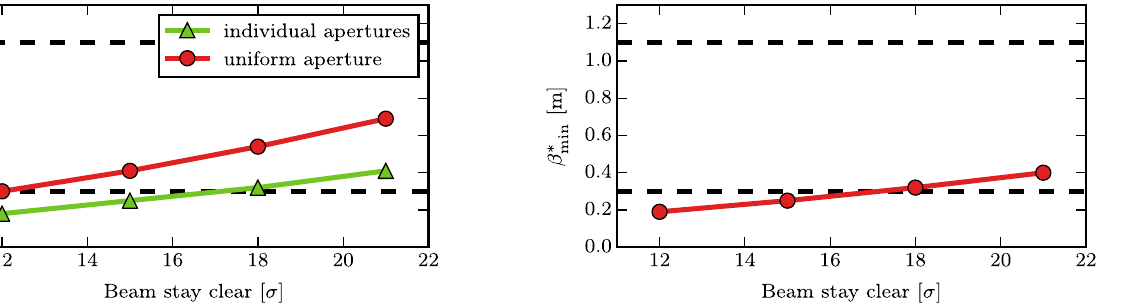
FIG. 7. Minimum β (cid:2) of the L (cid:2) ¼ 36 m lattice for beam star clear requirements of 12 – 21 σ . The baseline goal of β (cid:2) ¼ 1 . 1 m poses no problem from the aperture point of view. The “ ultimate ” goal of β (cid:2) ¼ 0 . 3 m can barely be reached with uniform apertures. With individual apertures, the baseline can be reached or exceeded within a beam stay clear of up to ≈ 17 σ .